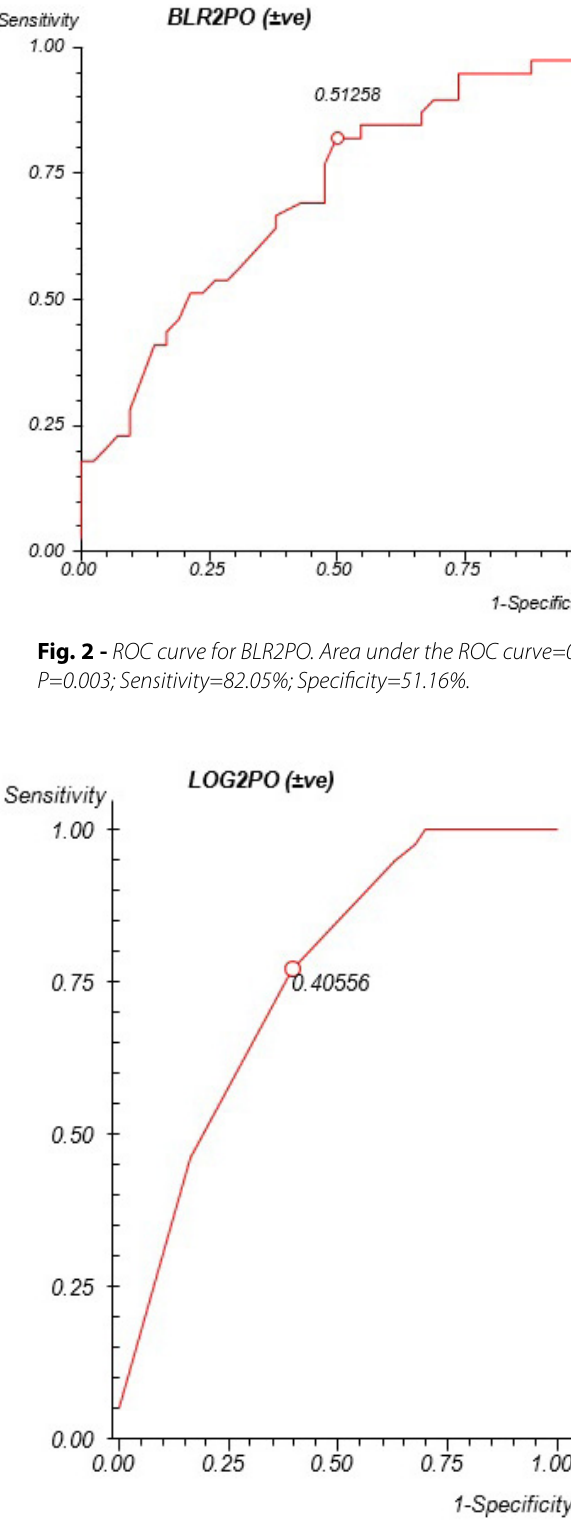
Fig. 3 - ROC curve for LOG2PO. Area under the ROC curve=0.723; P=0.0001; Sensitivity=74.36%;